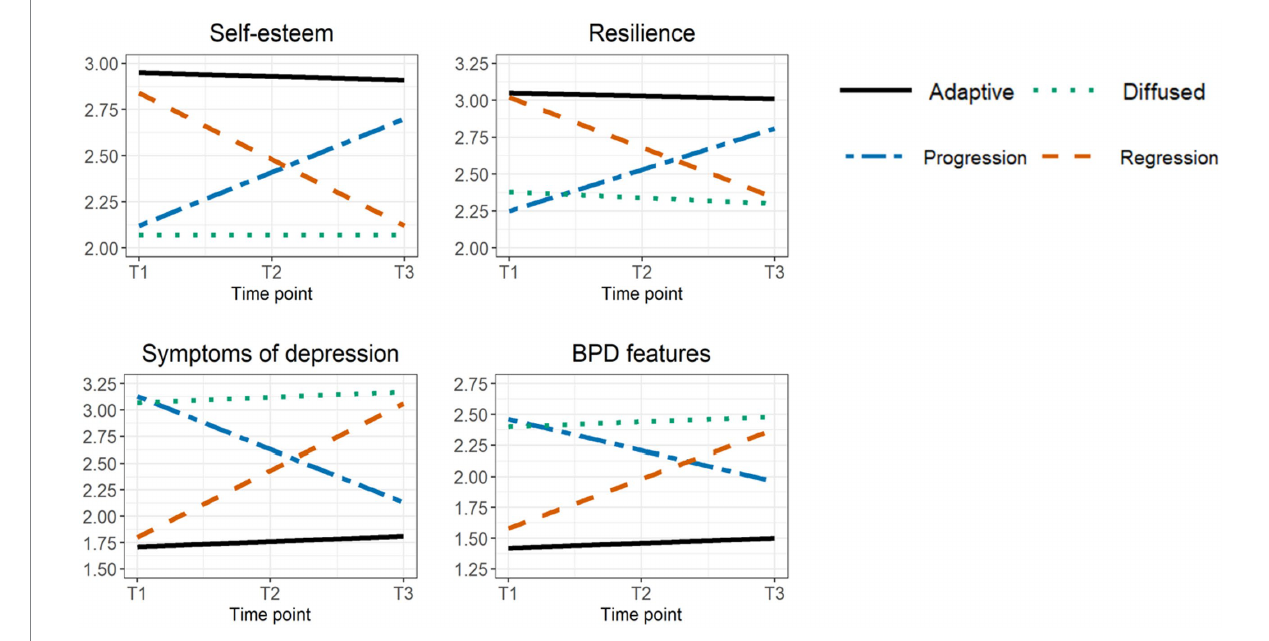
FIGURE 2 Parameter estimates of self-esteem, resilience, symptoms of depression, and BPD features for the four-class solution in